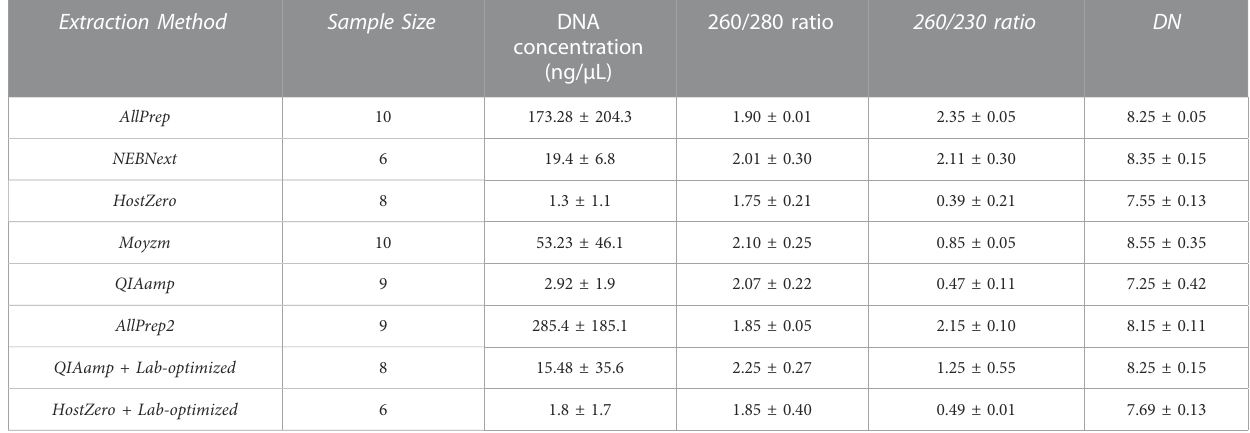
TABLE 1 Quality control of DNA extracted by the multiple kits from endoscopic biopsy samples. DNA concentration, purity, and DNA integrity number (DIN) are recorded for each sample. The average values with standard deviations (±) are shown for each